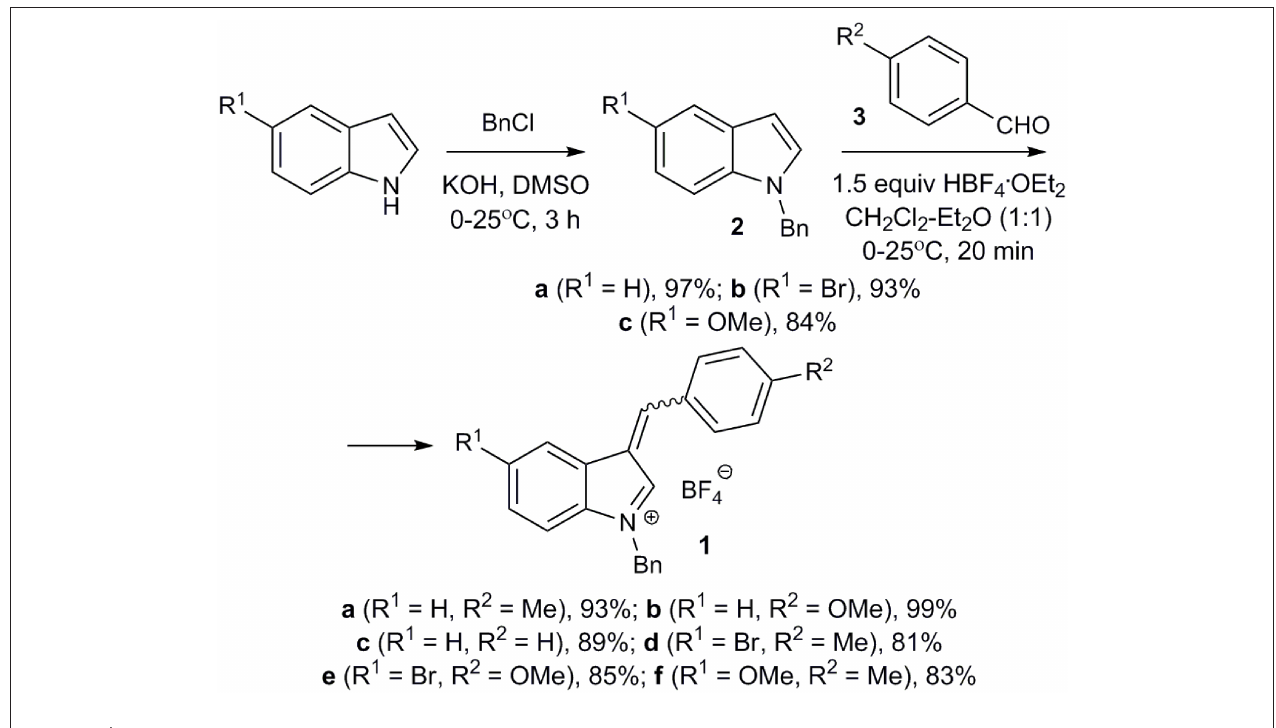
FIGURE 2 | Synthesis of 3-arylidene- 3H -indolium salts 1 .